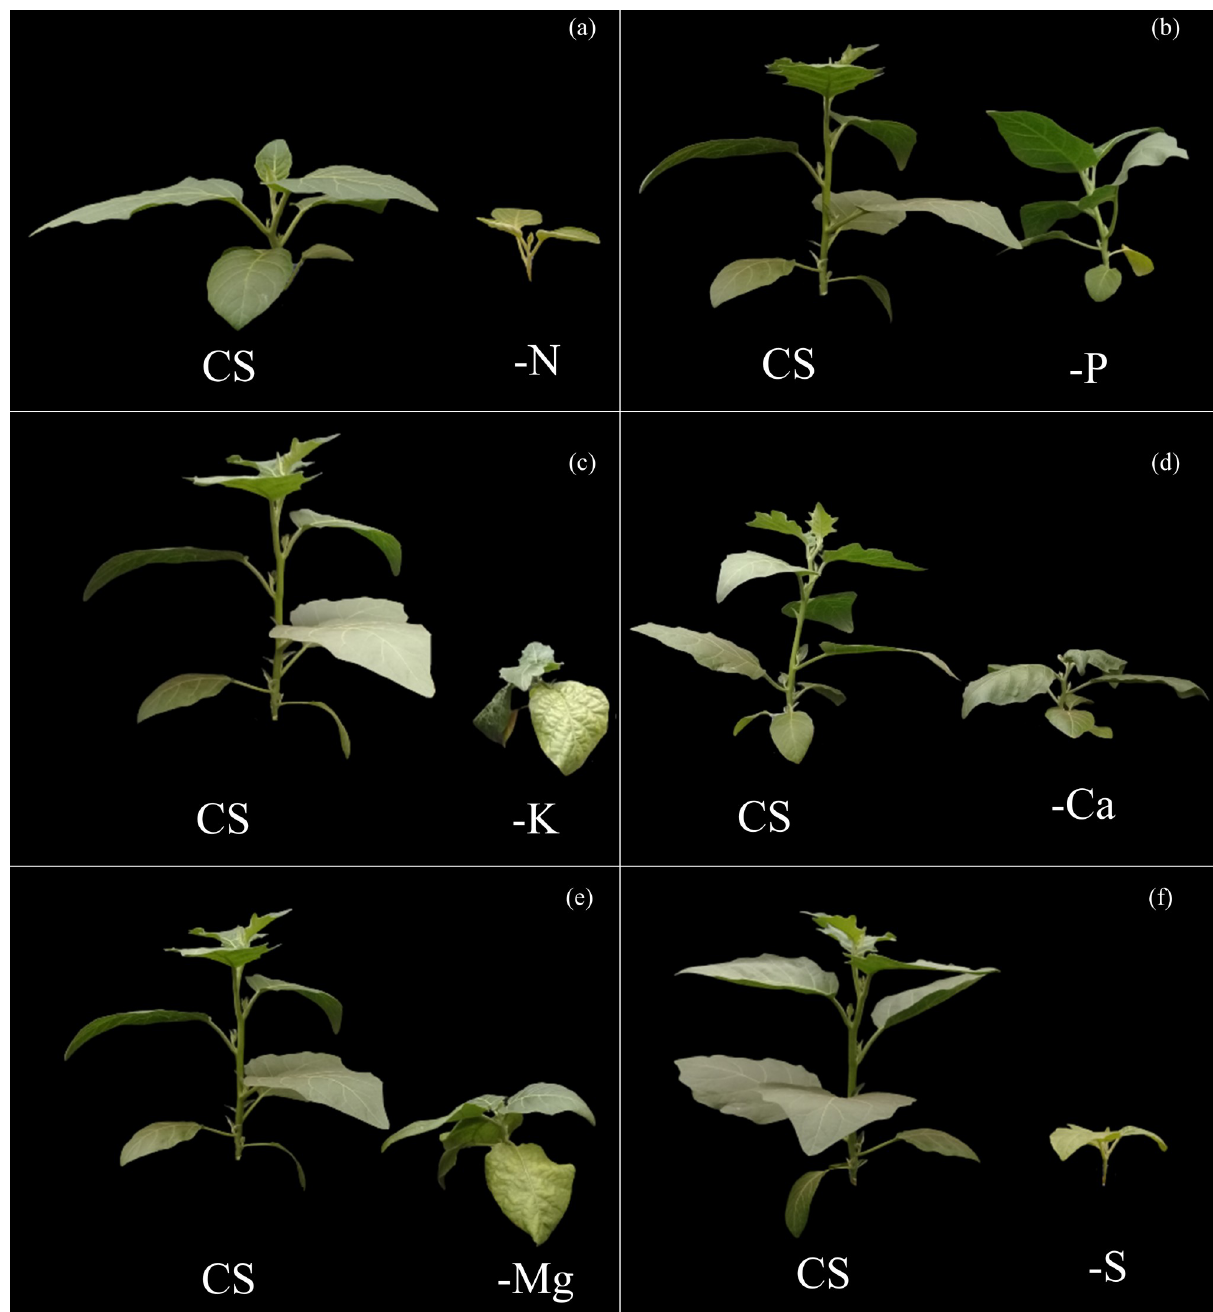
Fig 6. Side view of scarlet eggplants with visual symptoms of nitrogen deficiency (-N) (a), phosphorus (-P) (b), potassium (-K) (c), calcium (-Ca) (d), magnesium (-Mg) (e) and sulphur (-S) (f) compared to the complete solution (CS).